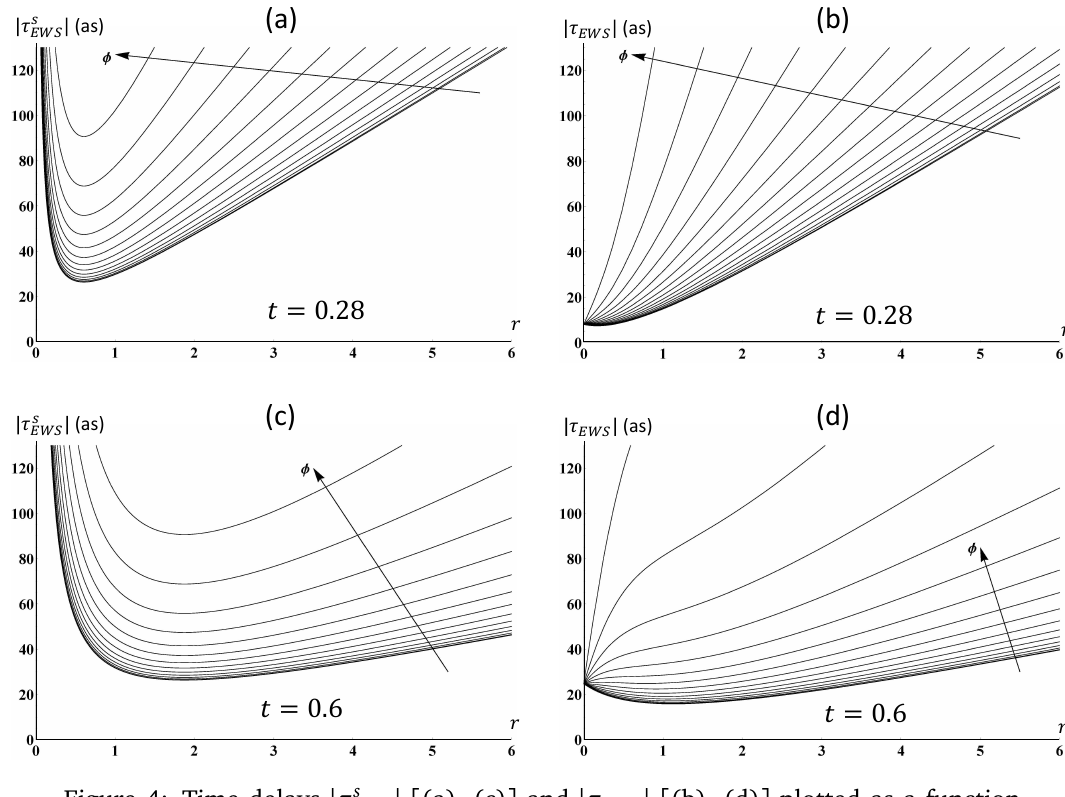
| [ (a), (c) ] and | τ | [ (b), (d) ] plotted as a function Figure 4: Time delays | τ s EWS EWS of r for two values of t : t = 0.28 [ (a), (b) ] and t = 0.6 [ (c), (d) ] . Every figure shows several plots for different values of φ ranging from 0 to π/ 2 (same trend for s φ ranging from 0 to − π/ 2). The value of ˙ P is ˙ P = 0.04 eV − 1 s